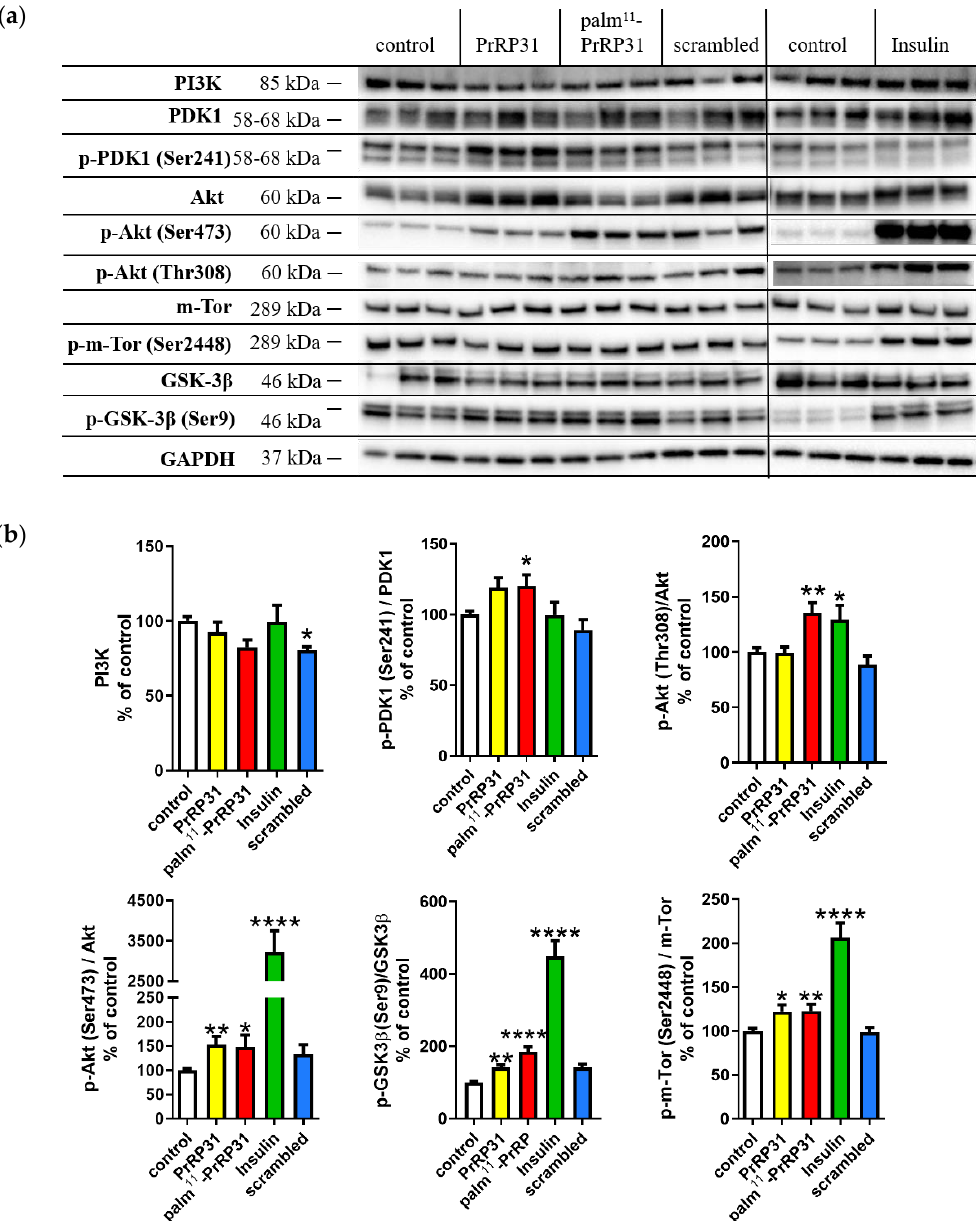
Figure 1. Prolactin-releasing peptide 31 (PrRP31) and palm 11 -PrRP31 increased phosphoinositide-3 kinase (PI3K / Akt) signaling pathway in SH-SY5Y cells. Immunoblots: ( a ) and their quantifications: ( b ). SH-SY5Y cells were incubated either with PrRP31 and its palmitoylated analog and scrambled at a final concentration 1 × 10 -5 M, or with insulin at the final concentration 1 × 10 − 7 M at 37 ◦ C for 8 min, or medium alone (control). Activation was expressed as the ratio of the activated protein to the total amount of the protein, both normalized to loading control, glyceraldehyde 3-phosphate dehydrogenase (GAPDH). Data are presented as the means ± SEM as a percentage of control cells analyzed by one-way ANOVA followed by the Dunnett post hoc test, * p < 0.5, ** p < 0.01, **** p < 0.0001 ( n = 3, each sample in